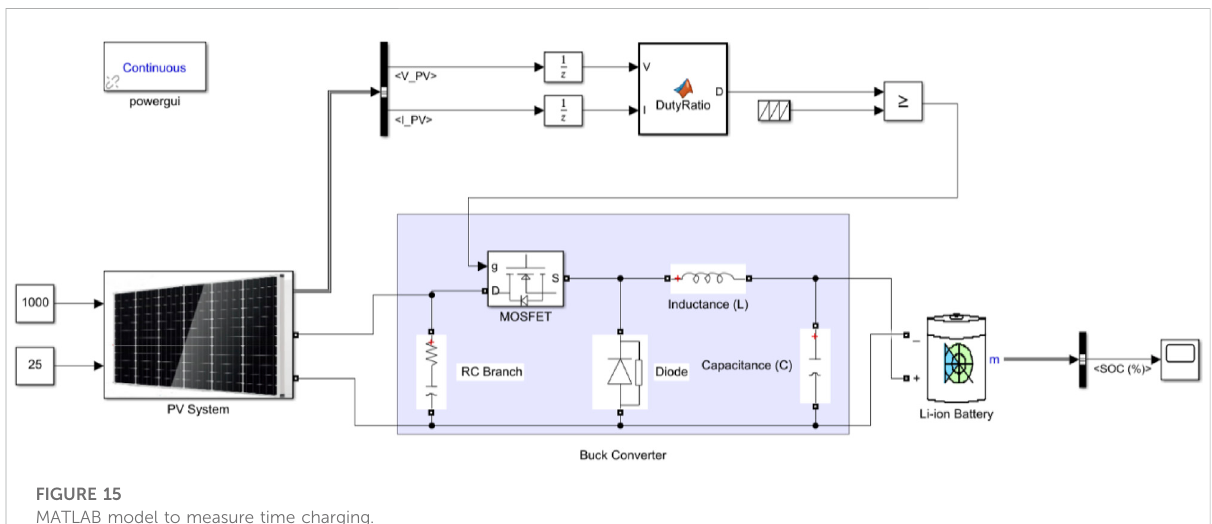
FIGURE 15 MATLAB model to measure time